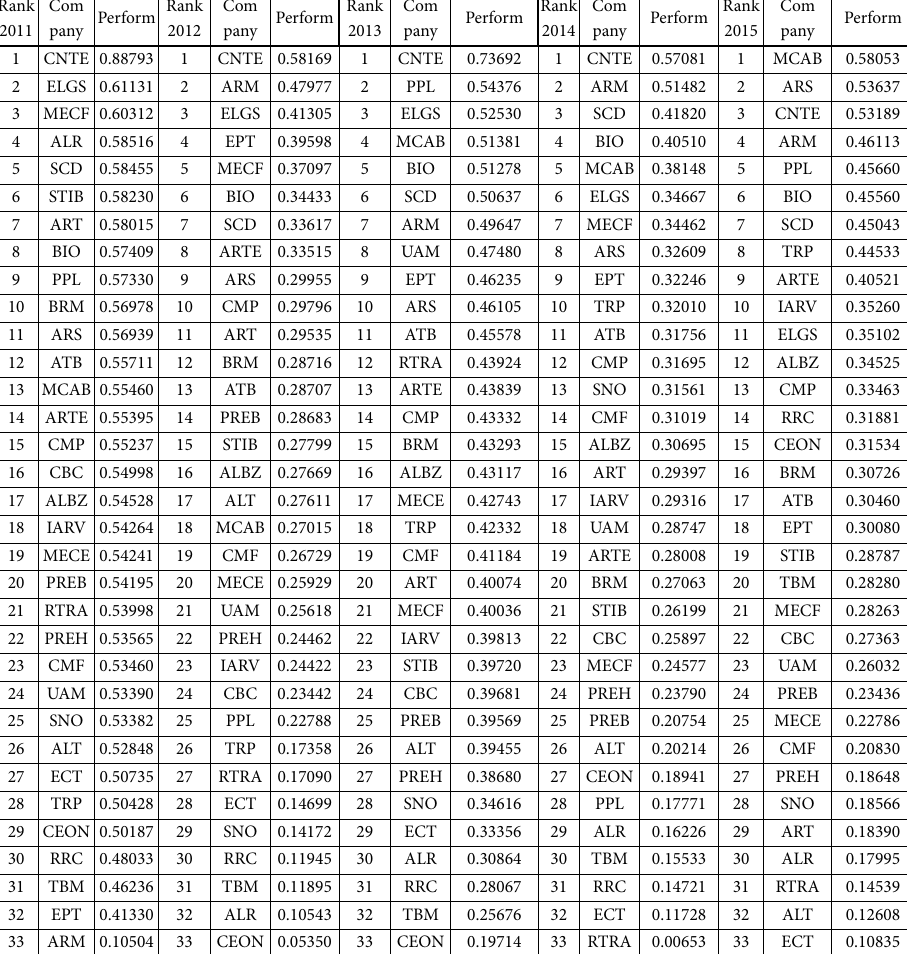
Table 9. Ranking of the companies in relation to AFP